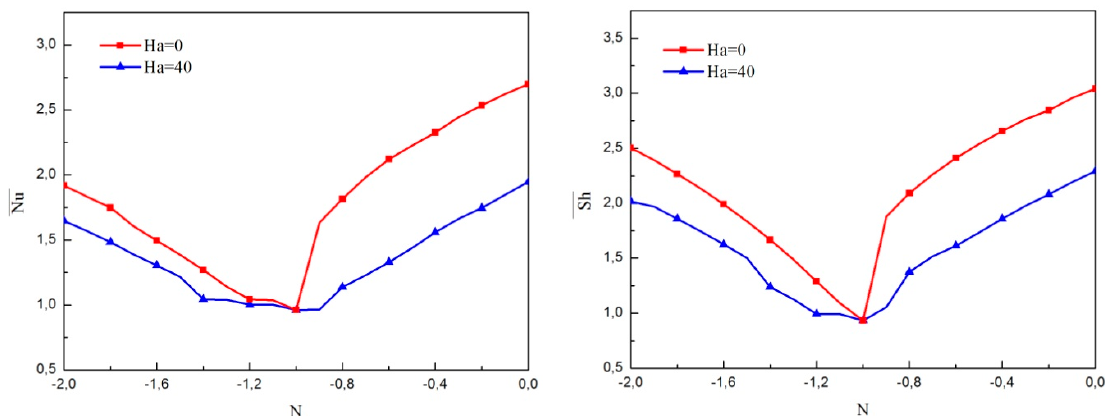
Figure 14. Variations of Nu(cid:3364)(cid:3364)(cid:3364)(cid:3364) and Sh(cid:3364)(cid:3364)(cid:3364) according to buoyancy ratio without (Ha = 0) and with magnetic field (Ha = 40) for Pr = 6.2, Le = 1, Ra = 10 5 and φ = 0.04.